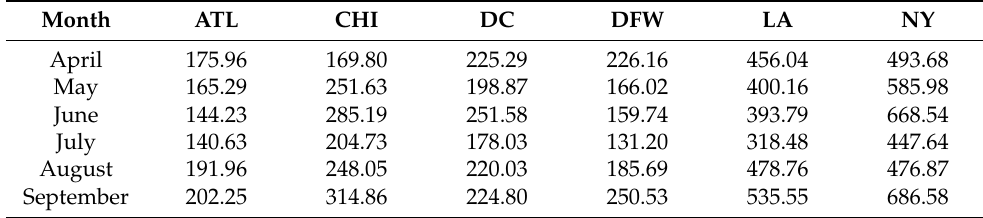
Table 3. Average daily heavy congestion amounts summarized by month (units: mileHours).